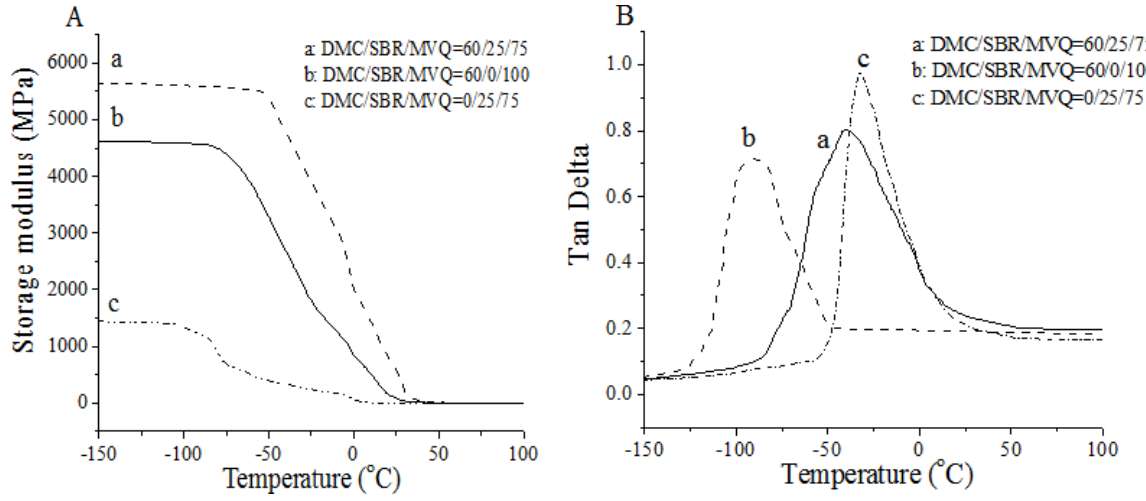
Figure 6: Storage modulus–temperature curves and Tan δ –temperature curves of DMC/SBR/MVQ